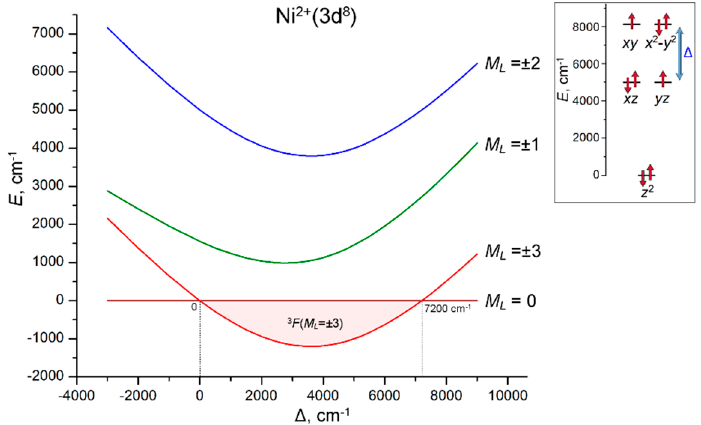
Figure 6. Variation of the energies of the 3 F ( M L ) LF states of Ni 2+ (3d 8 ) ion with increasing energy gap Δ = E ( xy , x 2 − y 2) − E ( xz , yz ). The range of the stabilization of the 3 F ( M L = ±3) ground state (0 ≤ Δ ≤ 7200 cm − 1 ) is marked with light pink. Inset: the LF splitting pattern of 3d orbitals, E ( z 2 ) = 0, E ( xz , yz ) = 5000 cm − 1 (fixed) and E ( xy , x 2 − y 2) = 5000 cm − 1 + Δ (variable). LF calculations are performed with atomic parameters B = 800, C = 3200 and ζ = 600 cm − 1 .